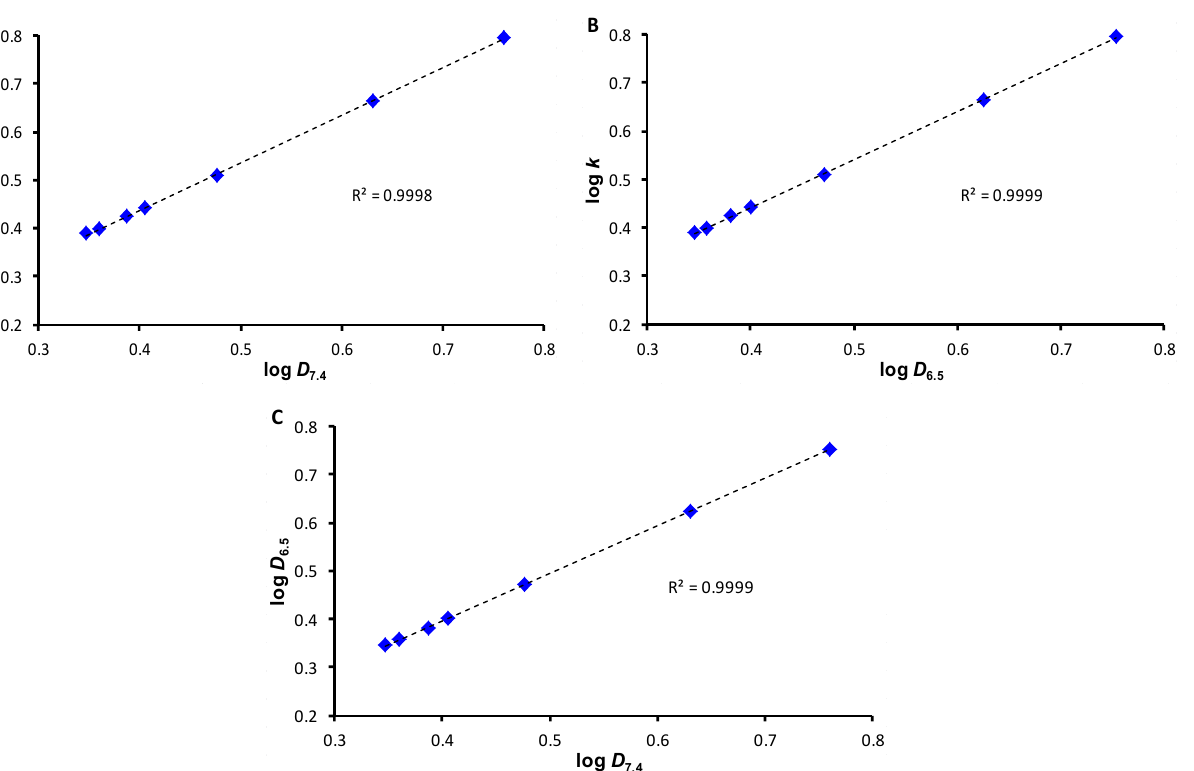
Figure 2. Comparison of predicted Clog P (ChemBioDraw) values with experimentally found log k ( A ), log D 7.4 ( B ), and log D 6.5 ( C ) values of ring-substituted (2 E )- N -aryl-3-[2-(trifluoromethyl)- phe- nyl]prop-2-enamides 1 – 7 .